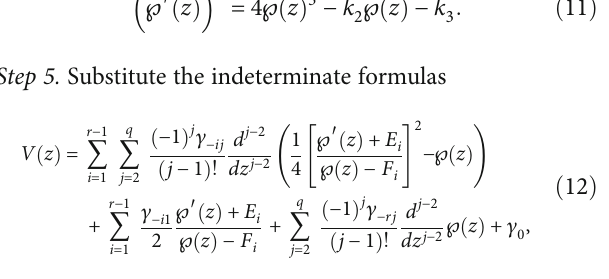
ð z Þ for the fi xed values v = 1 , z s ,1